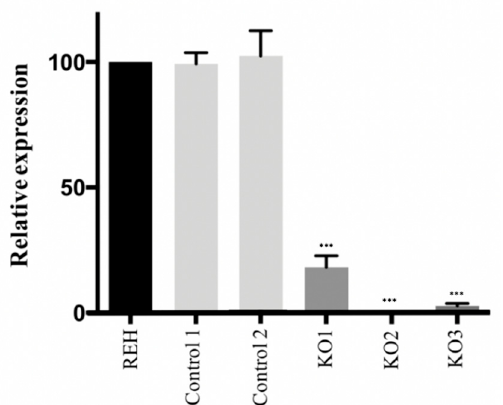
Figure 1. E / R expression levels by Reverse Transcription–quantitative real-time Polymerase Chain Reaction (RT-qPCR). Control clones showed an expression of E / R similar to it was observed in the parental REH cells. In E / R KO clones, whose sequence was edited by the CRISPR / Cas9 system, KO2 and KO3 showed a total loss of E / R expression and KO1 showed a leaky expression. All the experiments were carried out by triplicate, the means with the standard deviations for each clone were represented. *** p ≤ 0.001 (unpaired t -test).